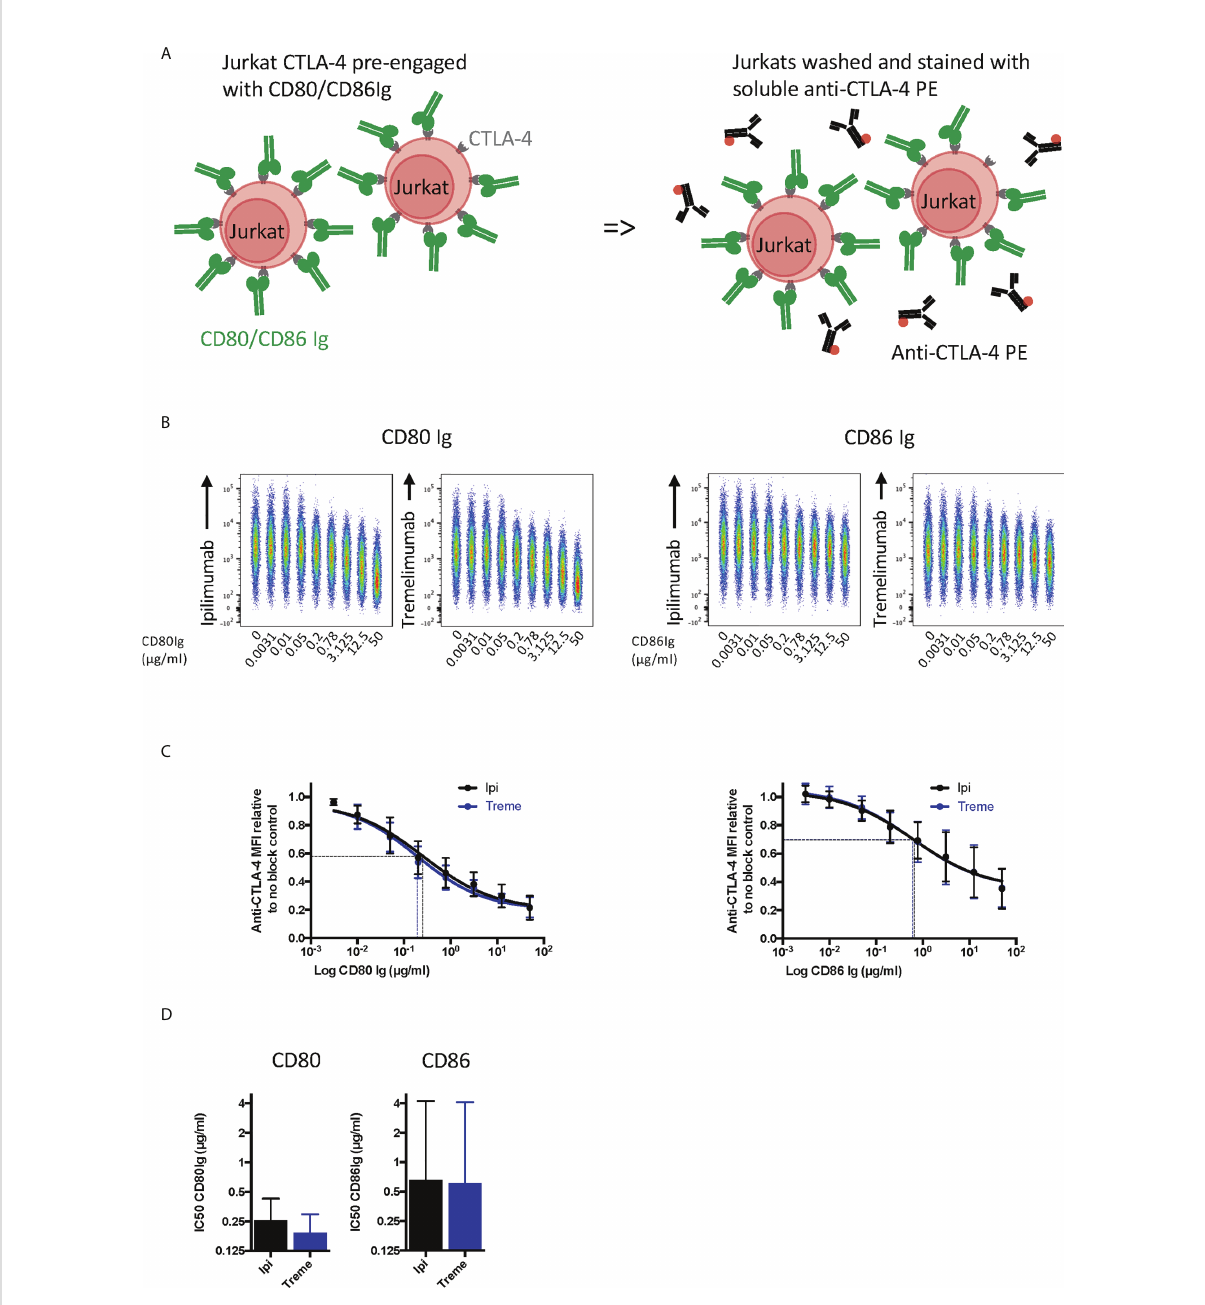
FIGURE 4 Pre-engagement of cell bound CTLA-4 with soluble CD80 and CD86Ig inhibits Ipilimumab and Tremelimumab from binding. (A) Schematic of experimental set-up. Jurkat cells expressing CTLA-4 were pre-incubated on ice with either soluble CD80 or CD86Ig to pre-engage CTLA-4 with ligand. Cells were washed, incubated with a fi xed dose (2µg/ml) of soluble PE conjugated anti-CTLA4 Abs and incubated on ice. Cells were washed and analysed for anti-CTLA-4-CTLA-4 binding by fl ow cytometry. All reagents/cells were chilled on ice before use. (B) Concatenated FACS plots show reduced anti-CTLA-4 engagement as the dose of CD80 or CD86Ig was increased. CD80 or CD86Ig doses were Log(x) transformed and dose response curves fi t using Prism v6 to obtain Log IC 50 for ipilimumab (Black line) and tremelimumab (Blue line). (C) CD80 or CD86Ig doses were Log(x) transformed and dose response curves fi tted using Prism v6 to obtain Log IC50 for ipilimumab (Black line) and tremelimumab (Blue line). (D) Graphs show the mean IC 50 with 95% con fi dence interval calculated using Prism v6. Data for ipilimumab and tremelimumab were acquired in separate 96-well plates